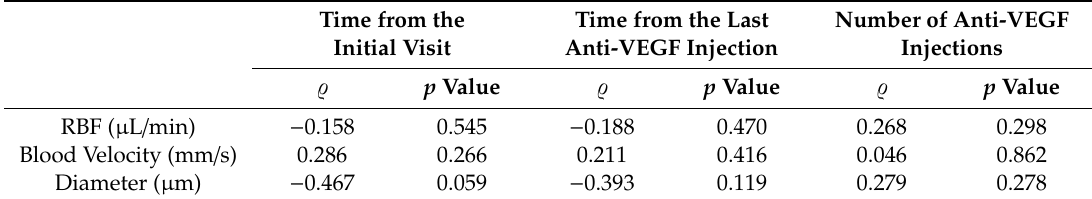
Table 3. Correlation between the RBF parameters on the occluded vein, and the time from the initial visit, the time from the last anti-VEGF injection and the number of anti-VEGF injections. Time from the Time from the Last Time from Time from the Last Number of Initial Visit Anti-VEGF the Initial Visit Anti-VEGF Injection Anti-VEGF Injections ρ